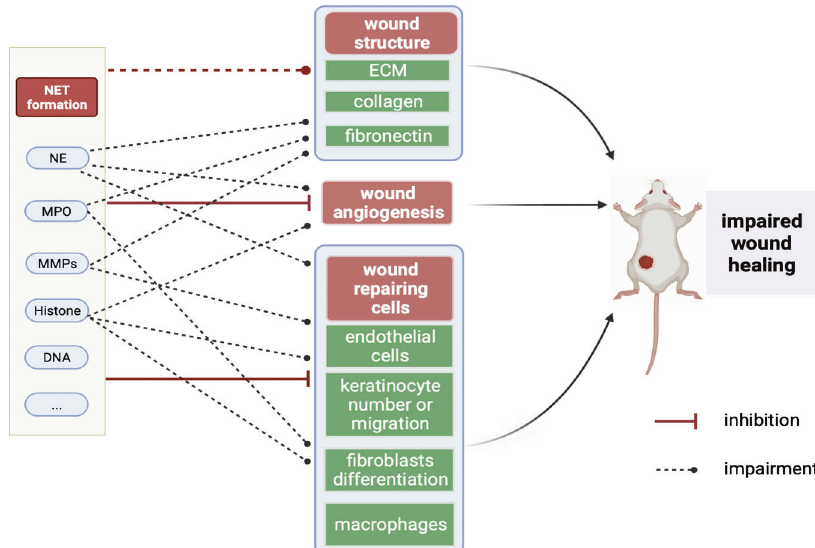
Fig. 2 Mechanisms of NET effects on wound healing. Excessive amounts of NET components such as neutrophil elastase, MPO, and MMPs can destroy wound structures, including collagen, fi bronectin, and cellular matrix. In addition, NETs impair angiogenesis in the wound area. NETs also affect the number or functions of wound-repairing cells, eventually leading to delayed wound